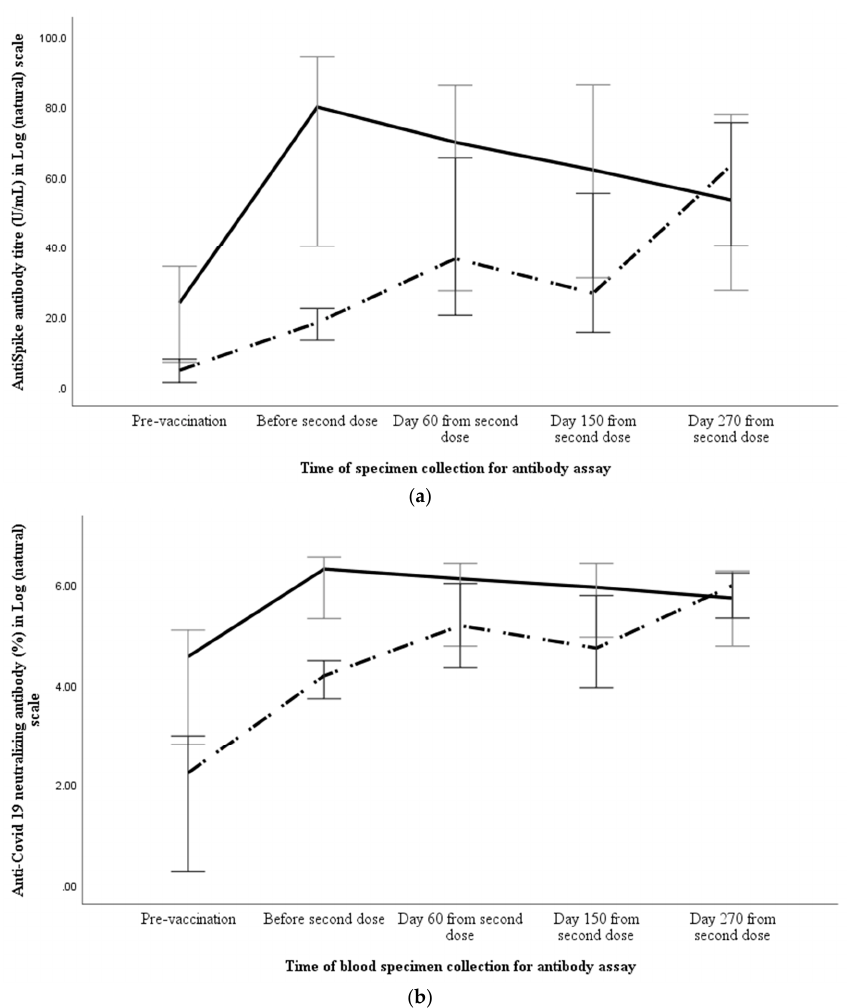
Figure 3. Comparison of anti-spike antibody titre ( a ) and percentage of neutralising antibody ( b ) between those with (solid line) or without (broken line) detectable anti-spike antibody before vaccination. The anti-spike antibody and neutralising antibody results, along with 95% error bar, are shown in Log (natural) scale along the Y axis, whereas X axis shows the time of specimen collection. We compared the ASAb and NAb between those who acquired COVID-19 infection (n = 29) or not (n = 106) after complete vaccination (Table 4). Their ASAb titres were com- parable after first dose ( p = 0.362) but were significantly higher at day 60 ( p < 0.001) and day 150 ( p = 0.002) in those who acquired infection. The ASAb titres again became compa- rable at day 270 ( p = 0.306). Similarly, their NAb percentages were comparable at day 28